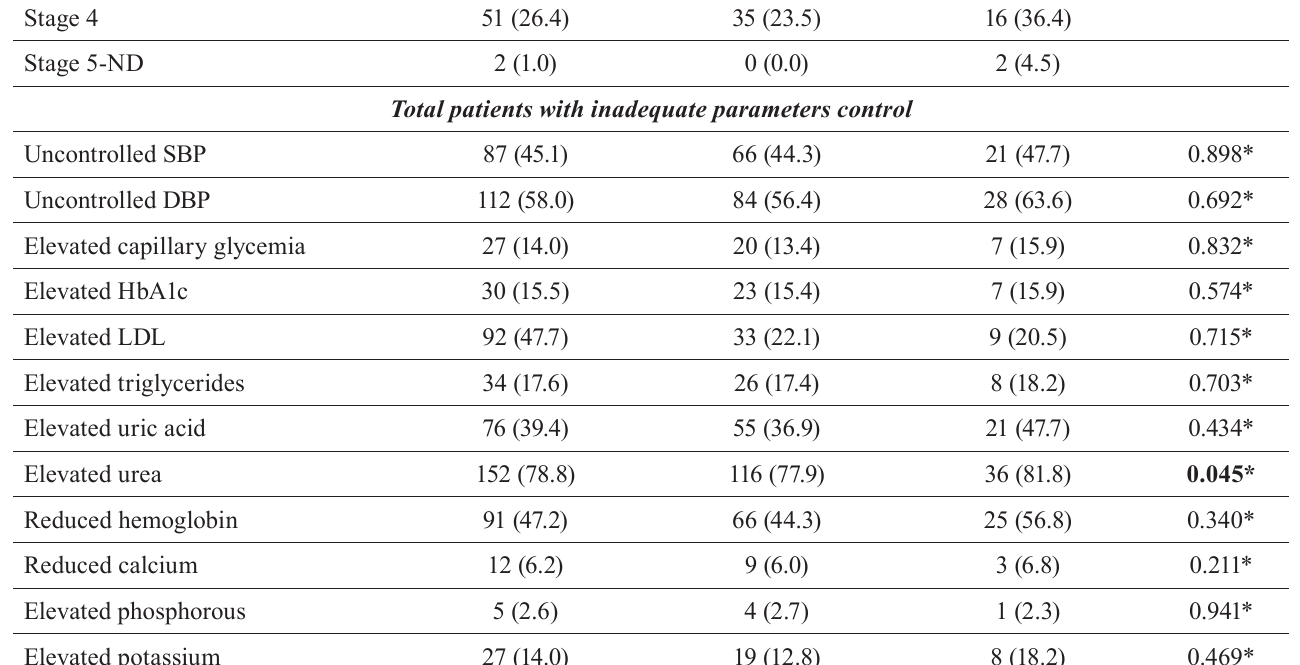
Table Legend: * Chi-square test; ** Data with abnormal distribution, expressed as median and interquartile range, non- parametric Mann-Whitney test; *** Fisher’s exact test. Legend: HbA1c: glycated hemoglobin; CKD: chronic kidney disease; LDL: low density lipoprotein; HDL: High density lipoprotein; SBP: systolic blood pressure; DBP: diastolic blood pressure; ND: